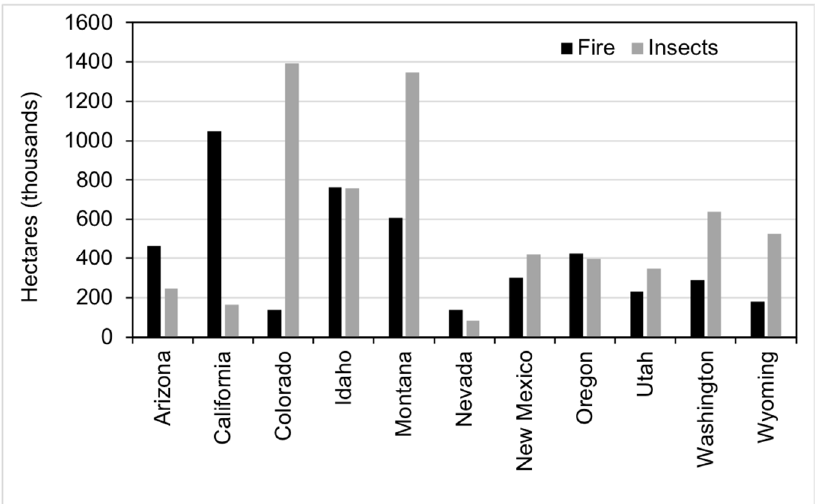
Figure 2. Thousands of hectares affected by bark beetle and fire over the past ten years in the western United States. To be considered affected, greater than 25% of the plot had to exhibit mortality due to fire or insects. Data from a full panel (10 years) of Forest Inventory and Analysis plots [13].